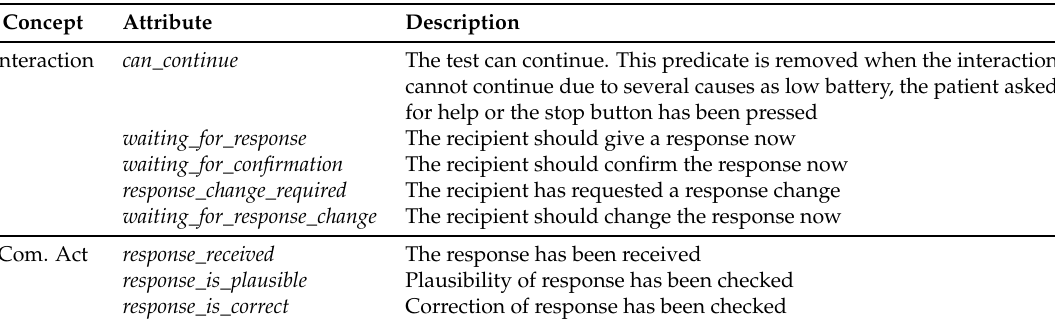
Table 3. Description of external